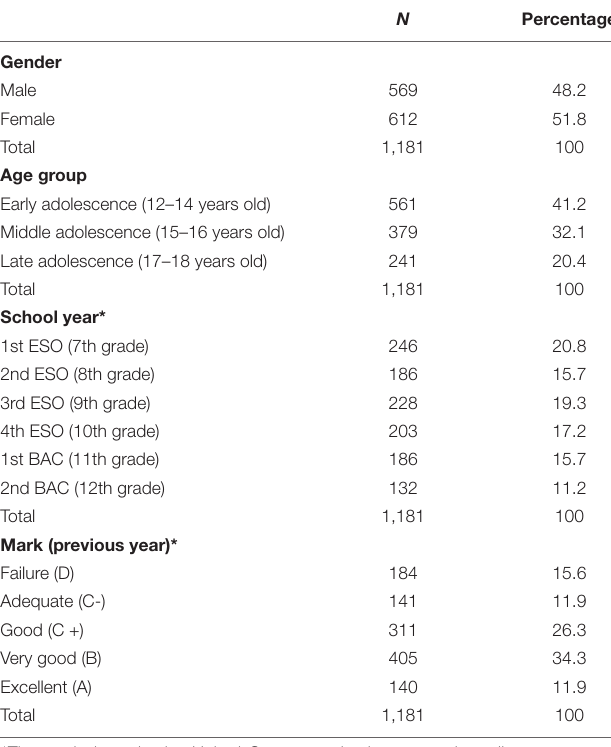
TABLE 1 | Distribution of the sample according to sociodemographic and academic